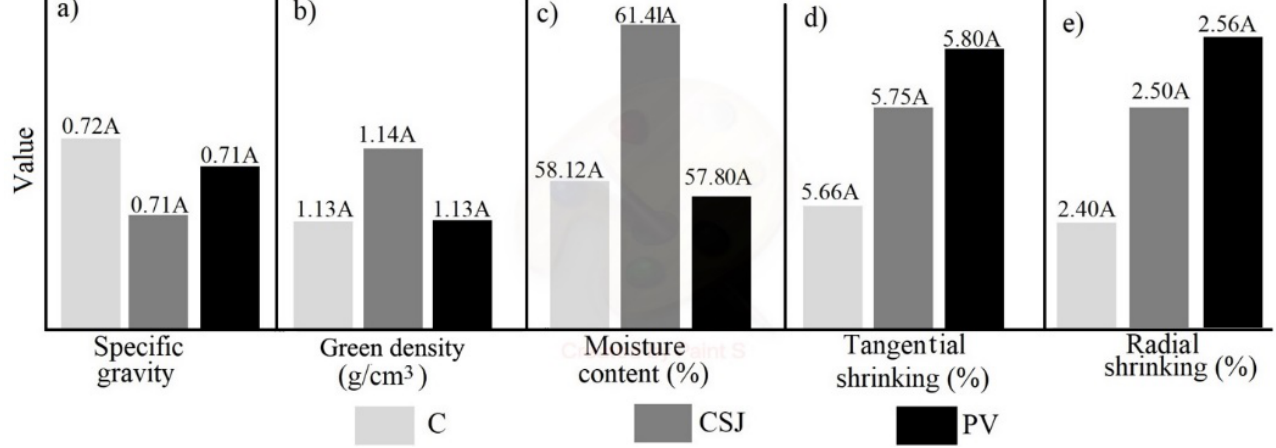
Figure 2. Physical properties at 8-years-old among native provenances of Dipteryx panamensis in Costa Rica: specific gravity-SG ( a ), green density-GD ( b ), green moisture content-MC-G ( c ), tangential shrinking ( d ) and radial shrinking ( e ). Note: Different letters indicate statistically significant dif- ferences at 99% among provenances.